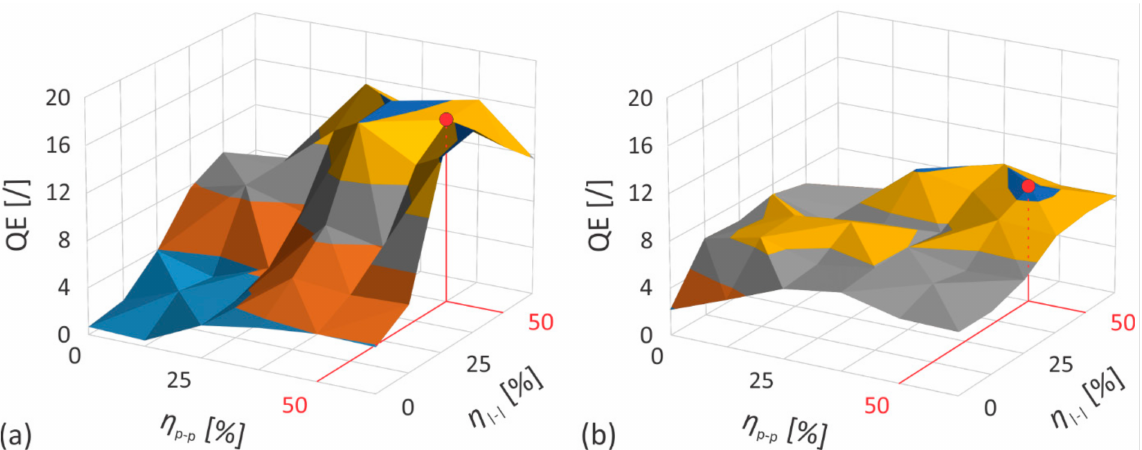
Figure 12. The evolution of QE as a function of pulse-to-pulse and line-to-line overlap when process- ing ( a ) brass CuZn37 and ( b ) steel AISI 316L,